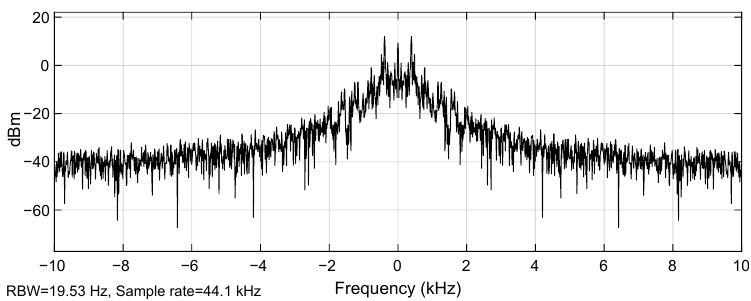
Figure 5. Baseband spectrum of the ACSK waveform (spread data